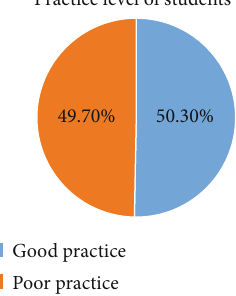
Figure 2: Practice level of students ’ towards HBV infection prevention at HUCMHS, Hawassa, Ethiopia,